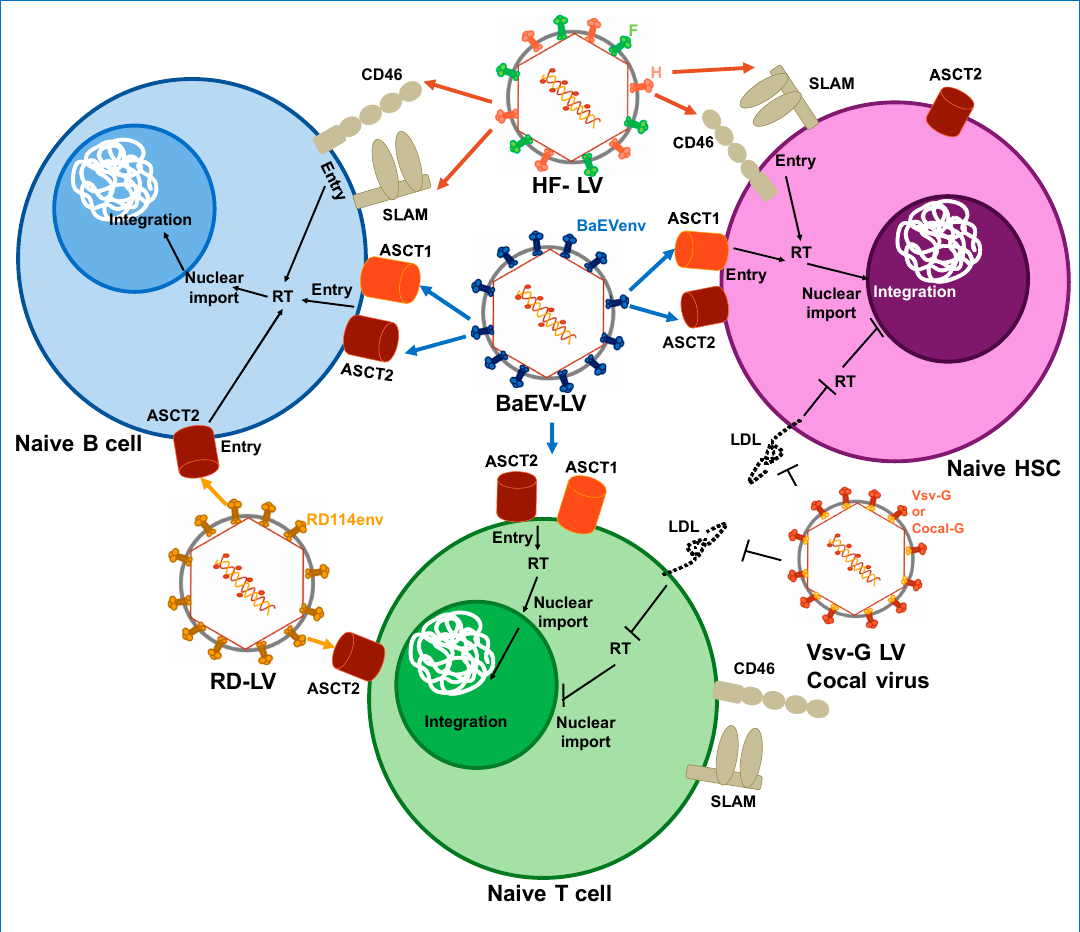
Figure 2. Pseudotyping of lentiviral vectors. Lentiviral vectors were generated expressing different envelopes from other viruses such as measles virus (HF), baboon envelope (BaEV) and feline endogenous retrovirus RD114 envelope gps (RD). They recognize receptors like the complement receptor CD46, signaling lymphocytic activation molecule (SLAM), sodium-dependent neutral amino acid transporters, ASCT-1 and ASCT2, expressed on resting hematopoietic stem cells (HSC), T cells and B cells. However, envelopes from vesicular virus (VSV-G) and Cocal virus recognize the low-density lipoprotein (LDL) receptor, which is poorly expressed on resting cells, which is the reason why they allow poor entry in these cells, and consequently, low level integration into the cell genome. Colored arrows indicate binding of the envelope gps to their respective receptors.